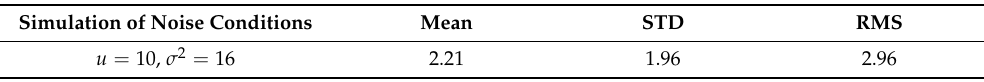
Table 6. Statistical results of matching location accuracy in the simulation.